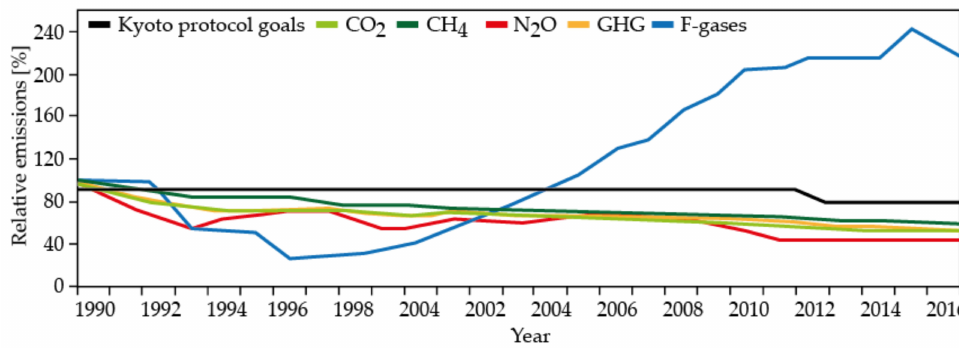
Figure 8. Comparison of relative greenhouse gas emissions trends with Kyoto protocol goals [73].